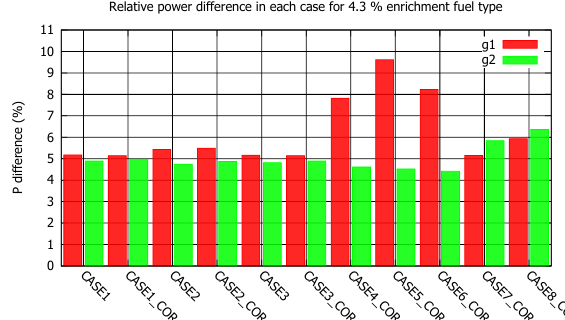
Relative power difference in each case for 4.3 % enrichment fuel type